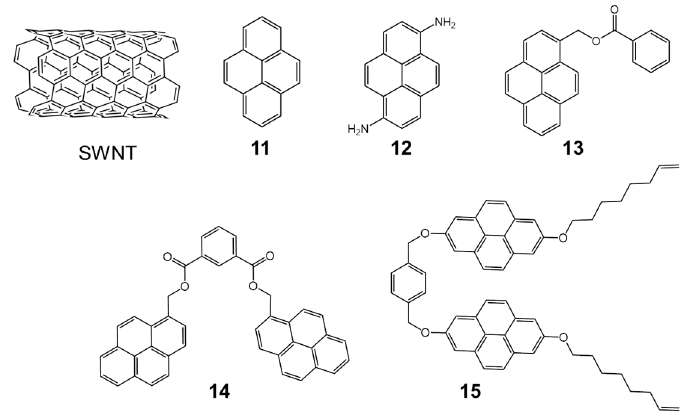
Figure 22. Chemical structure of a SWNT model and the hosts used to supramolecularly interact with SWNTs and test the experimental association constant protocol.